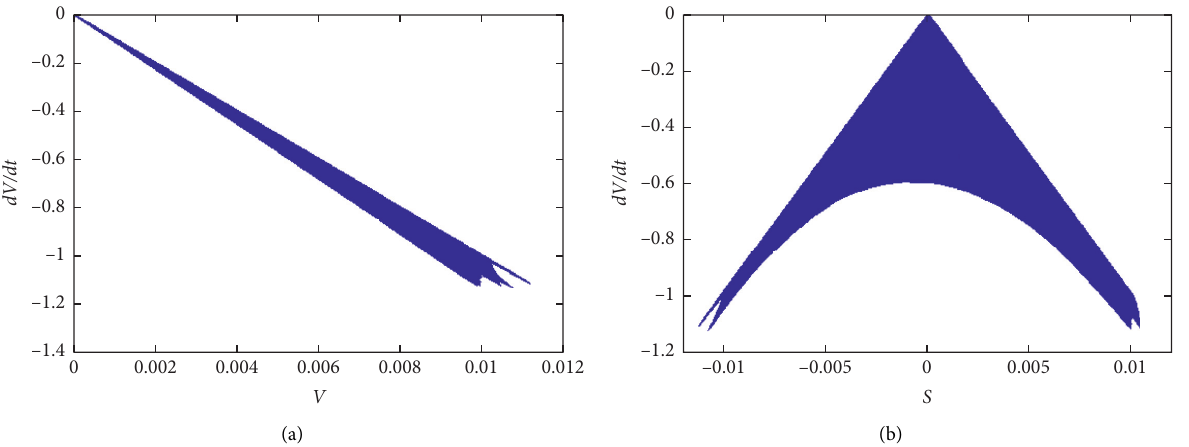
Figure 18: d V /d t versus V and s for the controlled system with η � 100. (a). d V /d t versus V , (b). d V /d t versus s